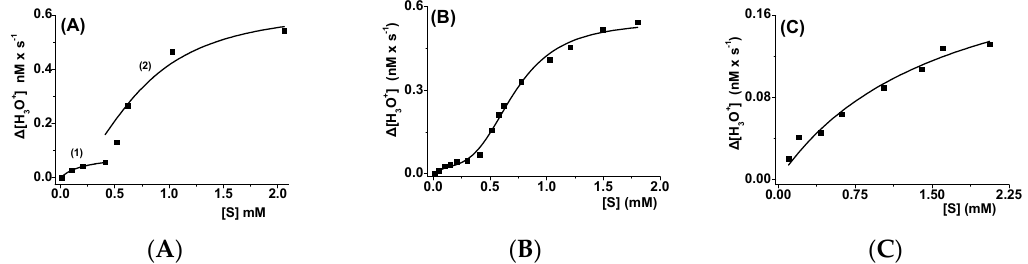
Figure 1. The kinetic data from the hydrolysis of pentaerythritol tetrastearate by CALB (curves ( A , B )) are discontinuous and may be split into two groups. In curve ( A ) (sub-curves A 1 and A 2 ), the data were fitted by Equation (2), i.e., are compatible with substrate activation conditions. In curve ( B ), there were more experimental data due to the higher number of parameters, and these fitted with Equation (3) as a whole. In contrast, the experimental data from the hydrolysis of the same substrate by PPL (curve ( C )) were fitted by the Michaelis–Menten Equation (1); saturation was not achieved due to the limited solubility of tetraester in the corresponding reaction mixture.